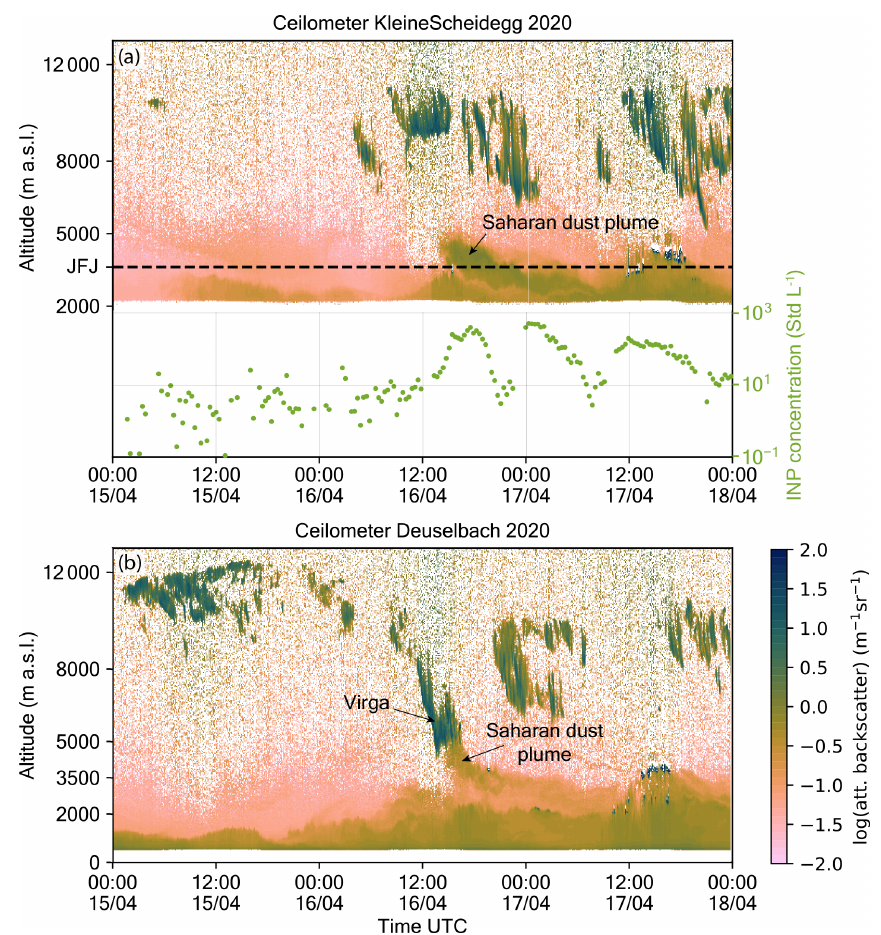
Figure 12. Vertical profile of the attenuated backscatter from the Kleine Scheidegg (KSE) and INP concentration at JFJ ( a ) and vertical profile of the attenuated backscatter from Deuselbach (DEU, b ), with the dust plume and connecting virga visible on 16 April between 06:00 and